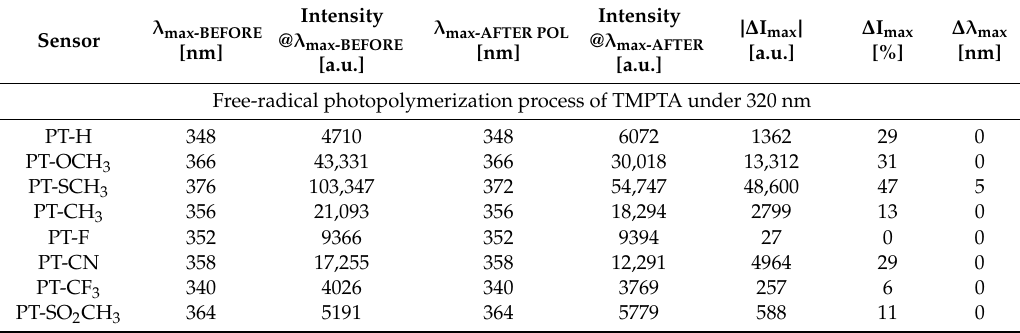
Figure 8. Monitoring the free-radical photopolymerization of the TMPTA monomer under 320 nm by FPT, using the 2,6-bis(4-methylsulphonylphenyl)pyridine as fluorescent sensor and ( a ) the R parameter and ( b ) the I 0 / I max parameter. Table 4. Spectroscopic data of 2,6-diphenylpyridine derivatives during the free-radical photopolymerization process.